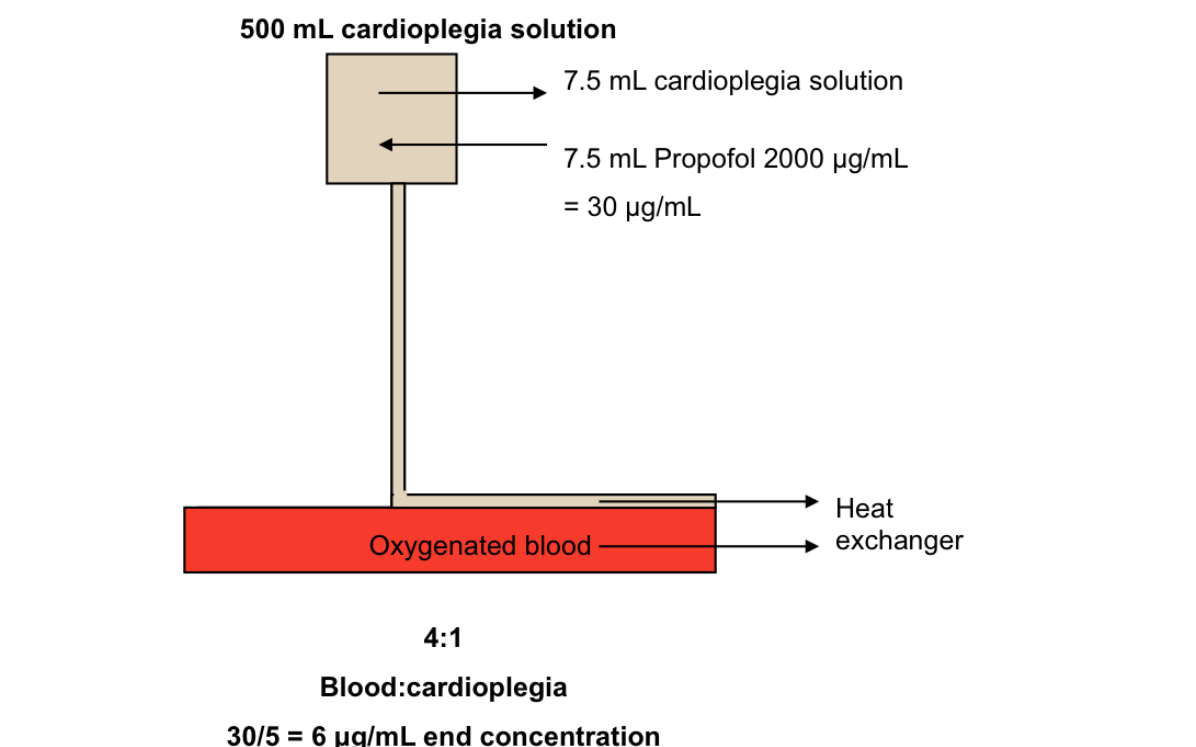
Figure 2. AVR cold blood cardioplegia. Propofol is first diluted from 10,000 μg/mL to 2000 μg/mL using 0.9% sodium chloride. Diluted propofol is added directly to a 500 mL bag of 4:1 cardioplegia solution by 1:1 (vol:vol) substitution. For the placebo group, cardioplegia is supplemented with placebo in exactly the same manner as described for propofol. In the event addition of propofol is indicated, this is substituted with an equivalent volume of